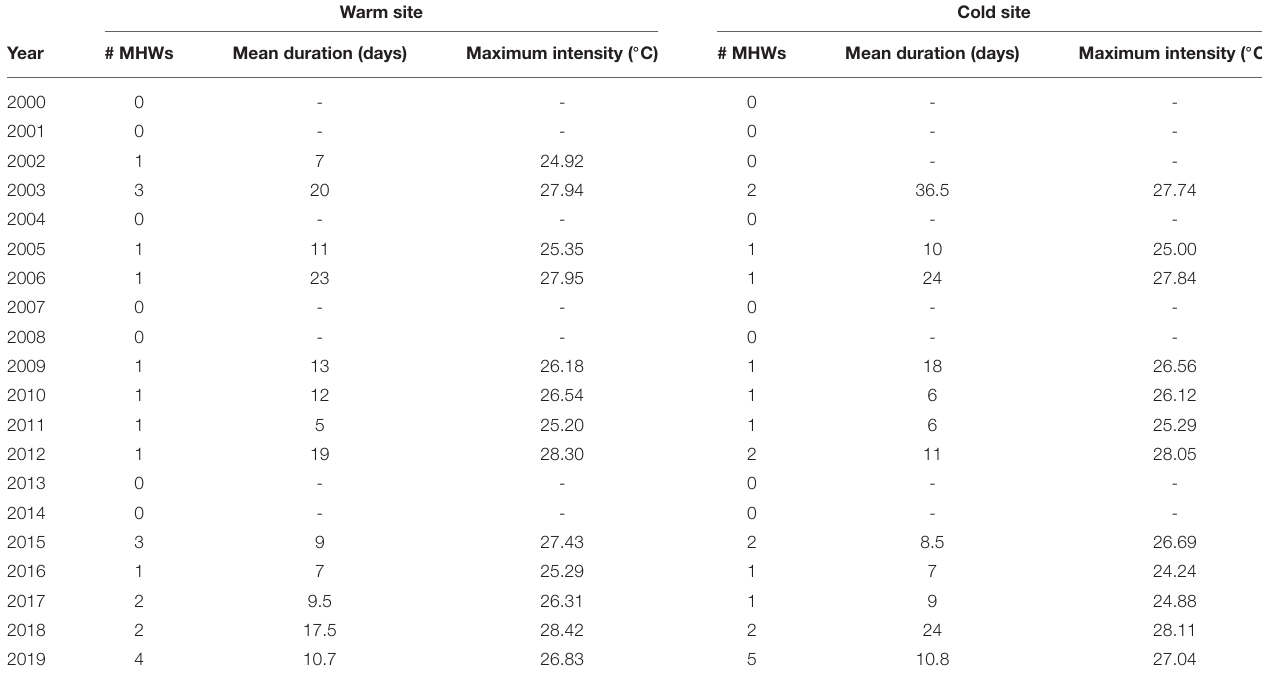
FIGURE 2 | Intensity and duration of the summer MHWs at the warm (left) and cold (right) site: in blue the 2000–2019 MHWs, in black the 2020 (current) MHWs and in red the common garden waves (future MHWs). TABLE 1 | Frequency, duration and intensity (Hobday et al., 2016) of the past summer MHWs at the two sites in the 2000–2019 period. Warm site Cold